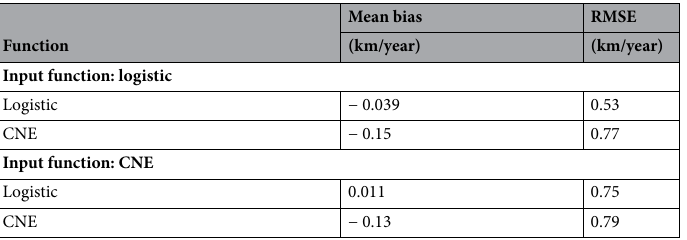
Table 4. Mean bias and root-mean-squared error when estimating the rate of spread c in the Puglia sampling strategy simulation with Gallipoli as the assumed origin. Bias is the average difference between the estimated value of the rate of spread, c , and the true value of this rate in km/year. RMSE root-mean-square error. CNE constrained negative exponential.